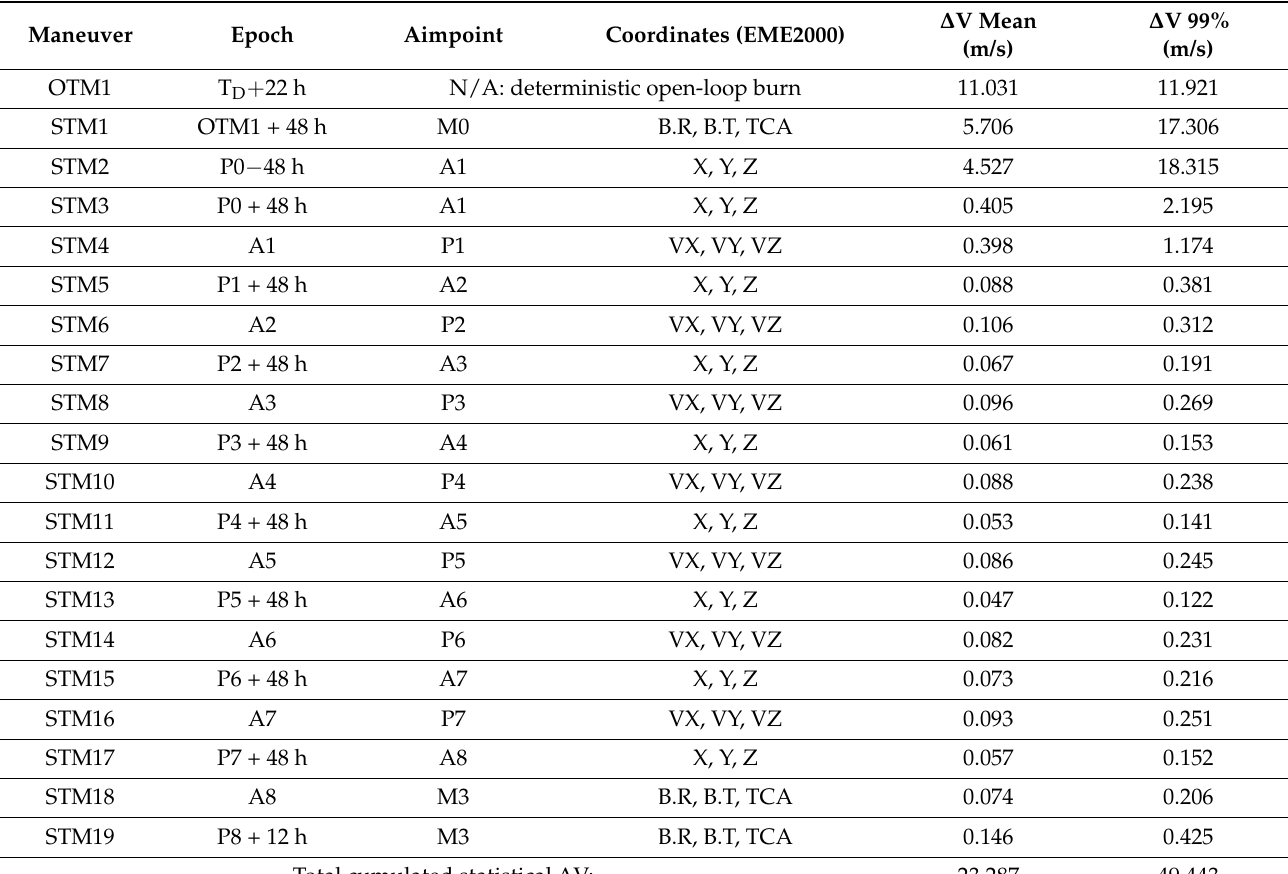
Table 4. Statistical ∆ V report of the entire mission generated through a Monte-Carlo simulation with 10,000 samples using the optimal trajectory control strategy described in the